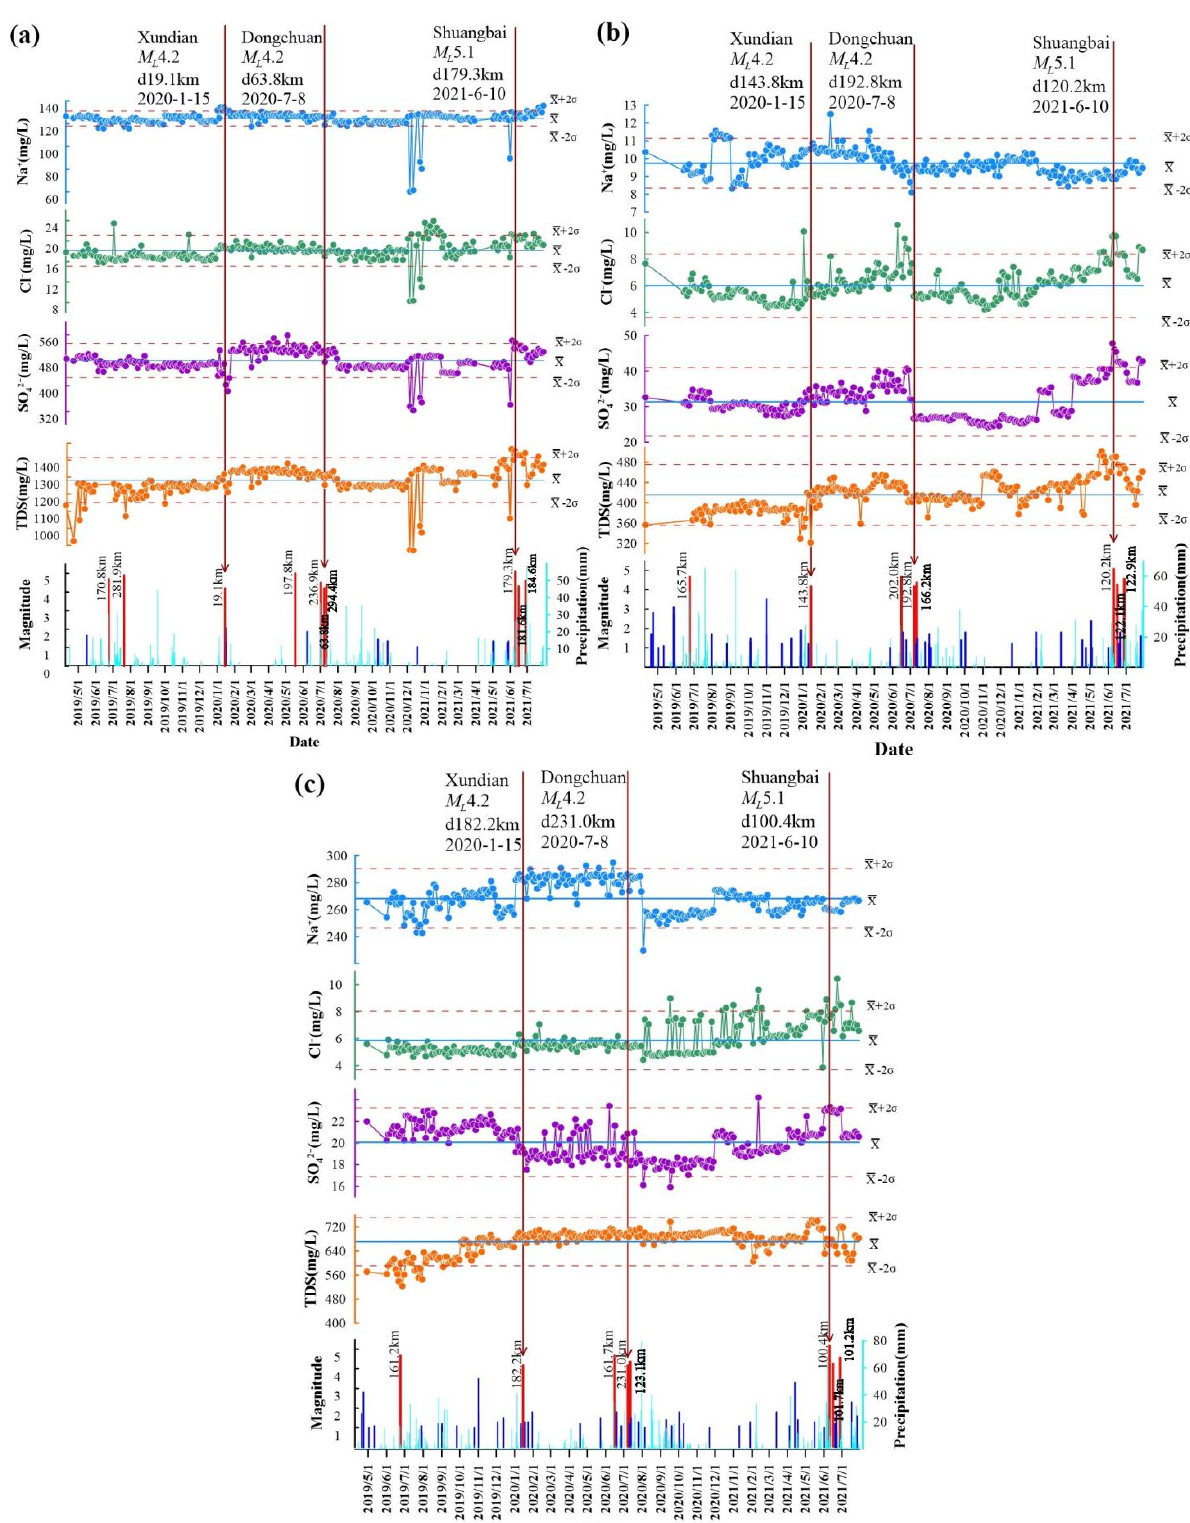
Figure 8. Temporal variations of concentration of Na + , Cl − , SO 4 2 − , TDS, precipitation, and earthquake: ( a ) is the Xundian spring (S7); ( b ) is the Panxi spring (S16); and ( c ) is the Qujiang hot spring (S9). Blue bars show the near-field earthquakes within 50 km and magnitude range from M L 1.0 to M L 4.0. Red bars show the far-field earthquakes within 300 km and magnitude range over M L 4.0. The precipitation means daily mean value.